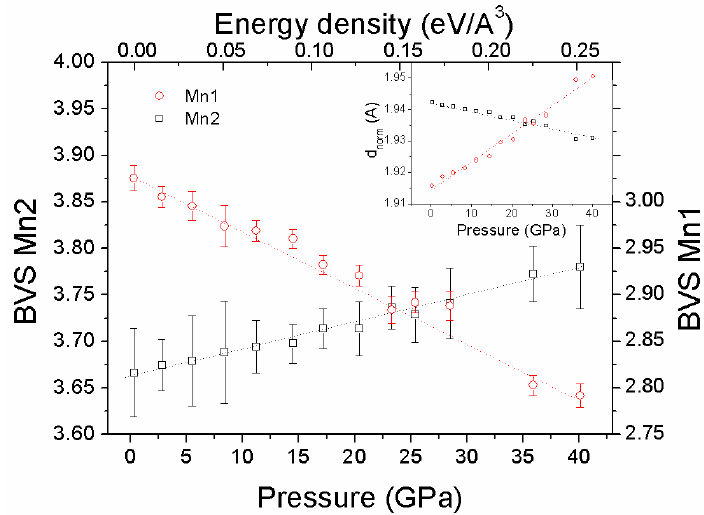
Figure 9. Bond Valence Sum and d norm values (inset) as a function of pressure for the Mn1 and Mn2 atoms. The two sites display an opposite trend, pointing to an intersite charge transfer taking place from the octahedral to the square planar coordinated site.